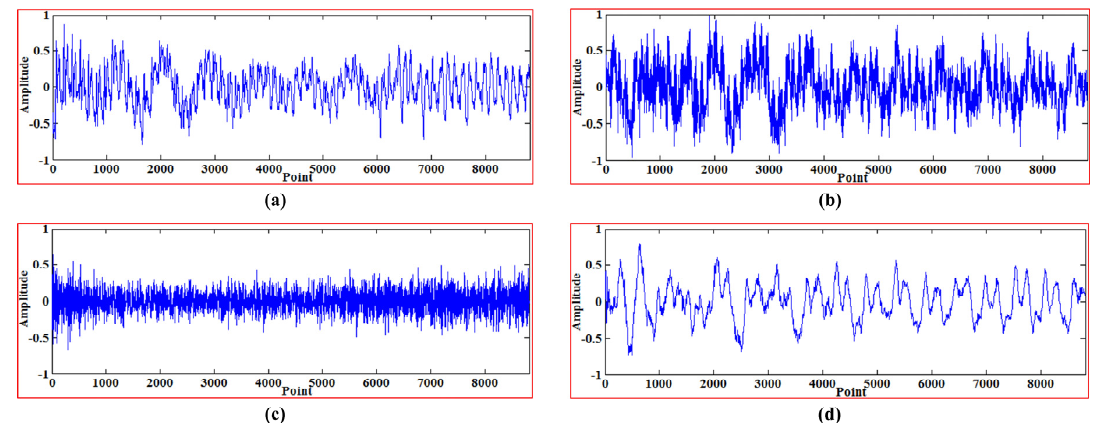
Figure 5. Four kinds of cutting sound signals. ( a ) Sound of coal seam with f2; ( b ) sound of coal seam with f3; ( c ) sound of coal seam gripping gangue; and ( d ) sound of no ‐ load.